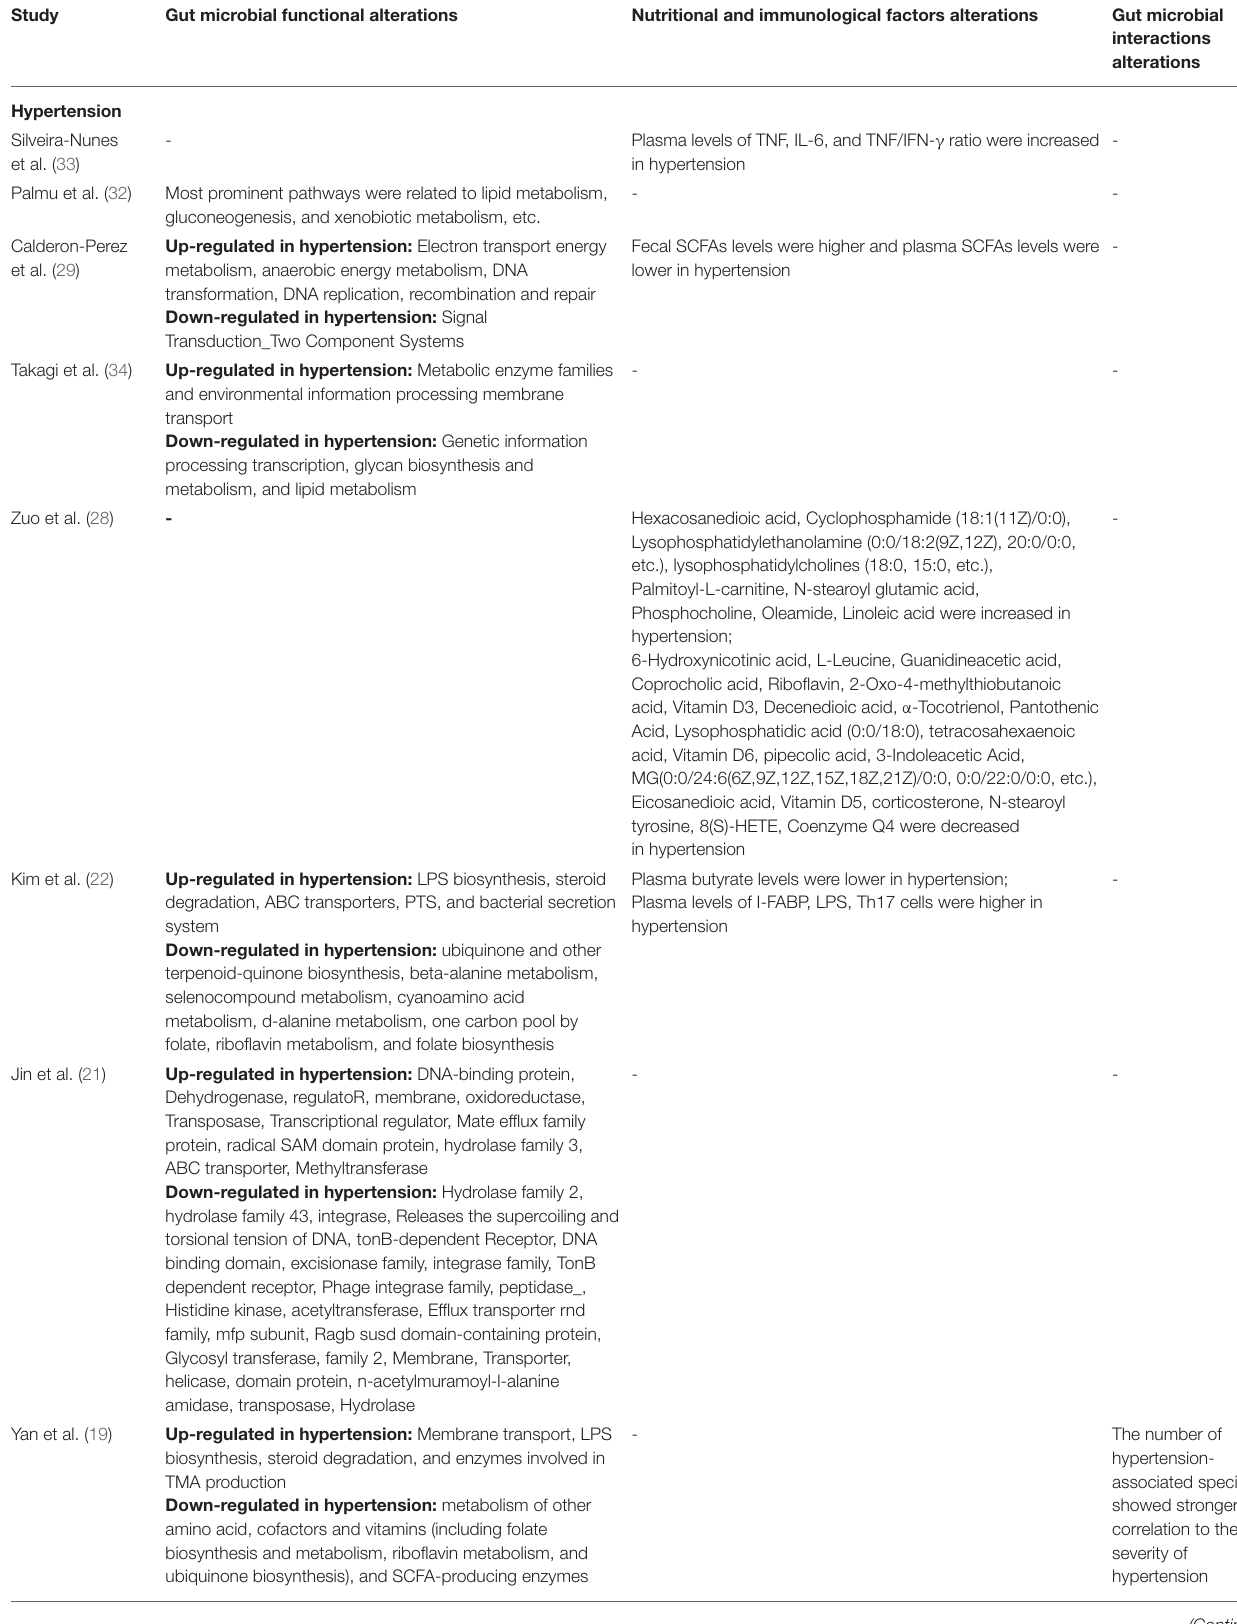
TABLE 4 | Major findings of microbiota functions, nutritional and immunological factors, and microbial interactions.